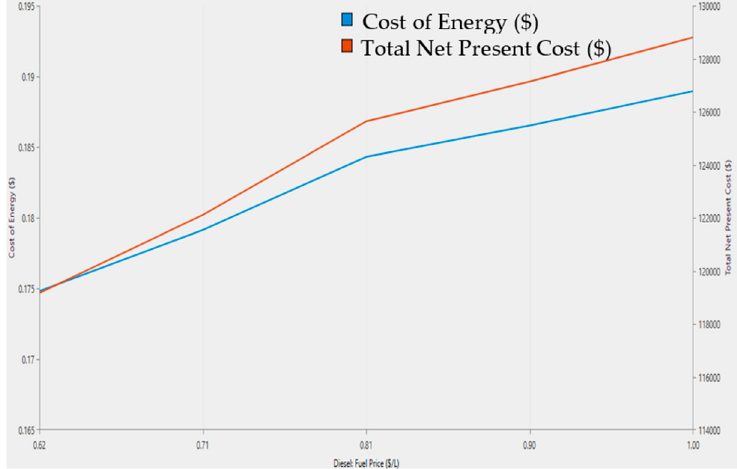
Figure 18. LCOE and TNPC related to diesel price variations.